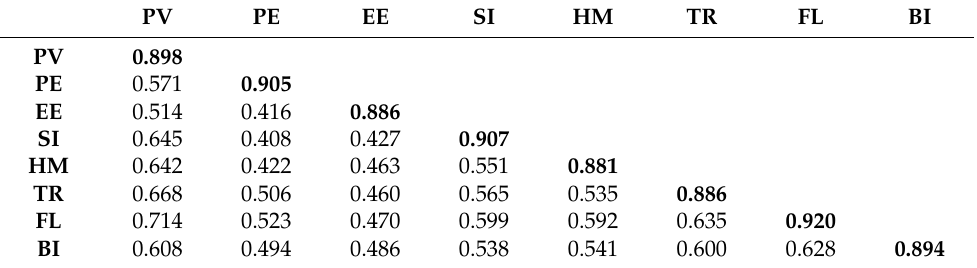
Table 4. Latent constructs’ square root of AVE and correlation.